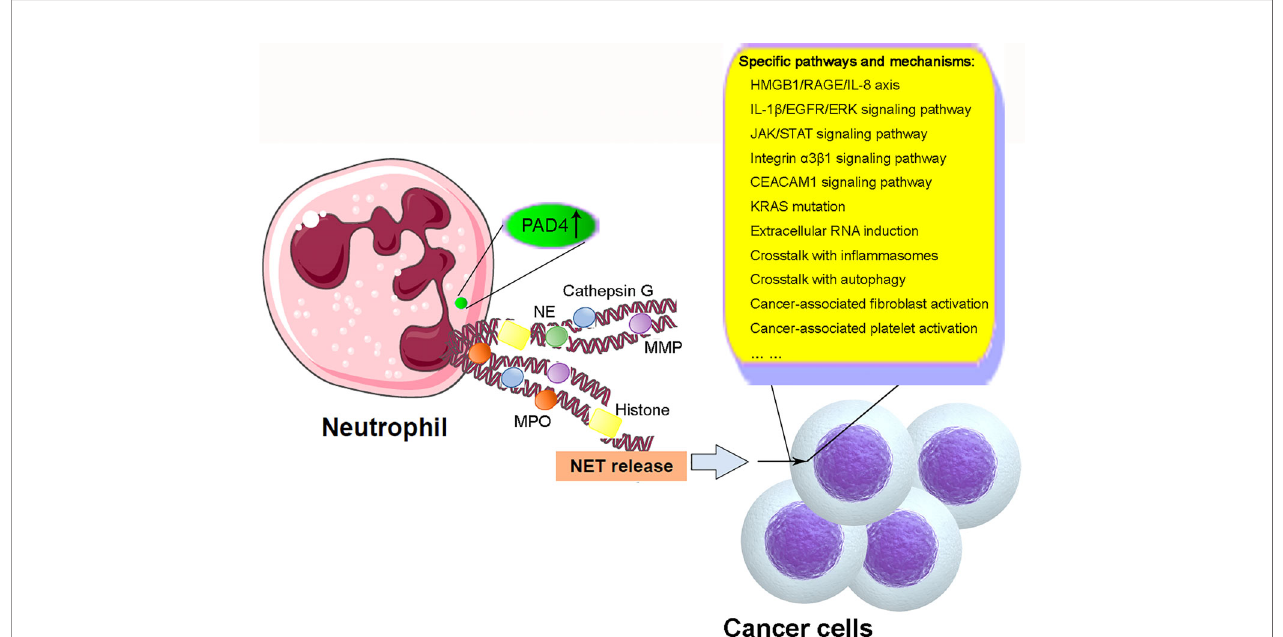
FIGURE 2 | Schematic illustration of mechanism of NETs in cancer. Under cancer-related stimulation, the level and function of PAD4 are enhanced, leading to the citrullination of histones and subsequent decondensation of chromatins. NET microvesicles with DNA-structural fi bers decorated by histones, MMP, NE, MPO, cathepsin G, and other granule proteins are extruded from neutrophils. NET formation modulates the biological characteristics of cancer cells in proliferation, differentiation, migration, and metastasis through the involvement and crosstalk with some speci fi c pathways and mechanisms including HMGB1/RAGE/IL-8 axis, IL- 1 b /EGFR/ERK signaling pathway, JAK/STAT signaling pathway, integrin a 3 b 1 signaling pathway, CEACAM1 signaling pathway, KRAS mutation, extracellular RNA induction and crosstalk with in fl ammasomes and autophagy, and cancer-associated fi broblast and platelet activation. NETs, neutrophil extracellular traps; PAD4, peptidyl arginine deiminase 4; MMP, matrix metalloproteinase; NE, neutrophil elastase; MPO, myeloperoxidase; HMGB1, high-mobility group box 1; RAGE, advanced glycation end products; EGFR, epidermal growth factor receptor; ERK, extracellular regulated protein kinase; JAK, Janus kinase; STAT, activator of transcription; CEACAM1, carcinoembryonic Ag cell adhesion molecule